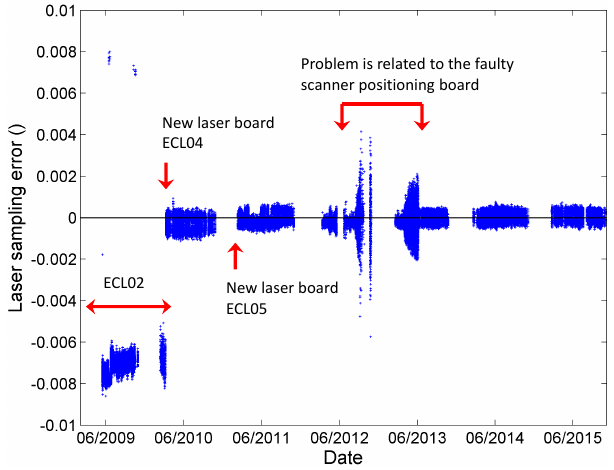
Figure 2. Laser sampling error (LSE) since 2009. LSE correction is applied during the retrieval process within GGG2014.